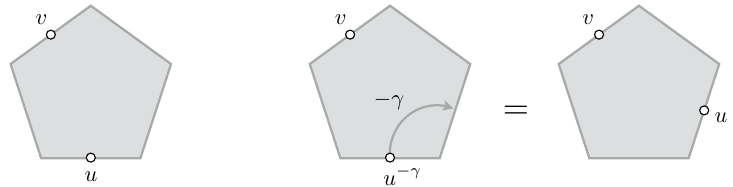
Figure 3 . Left panel: cartoon for pentagon transition P ( u j v ) between a (cid:13)ux tube excitation smeared with rapidity u at the bottom and one with a rapidity v at the top. Right panel: under the inverse mirror rotation (cid:0) (cid:13) : u ! u (cid:0) (cid:13) an excitation is moved anticlockwise to the neighbouring edge. The result is a pentagon transition with bottom and top being exchanged, P ( u (cid:0) (cid:13) j v ) = P ( v j u